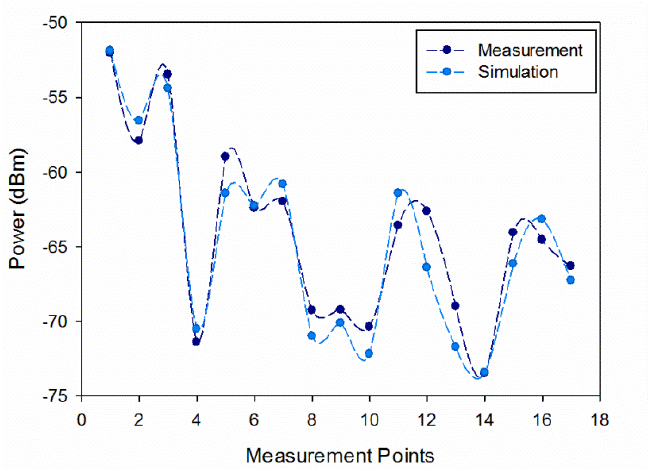
Figure 14. Comparison simulation versus measurements for 2.4 GHz frequency in the indoor passenger wagon